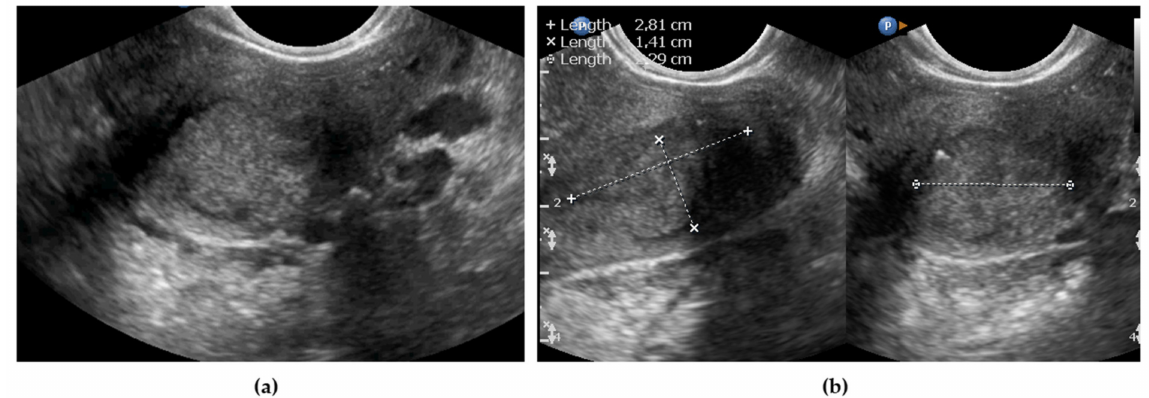
Figure 3. Tumor of the cervix in relation to the uterine corpus imaged using ultrasonography: ( a ) tumor does not involve the uterine corpus (calipers for tumor measurement); ( b ) tumor involves the uterine corpus (yellow arrows delineate the cervical tumor with involvement of the anterior wall of uterine corpus; blue arrows indicate the normal endometrium, lines indicate calipers on the